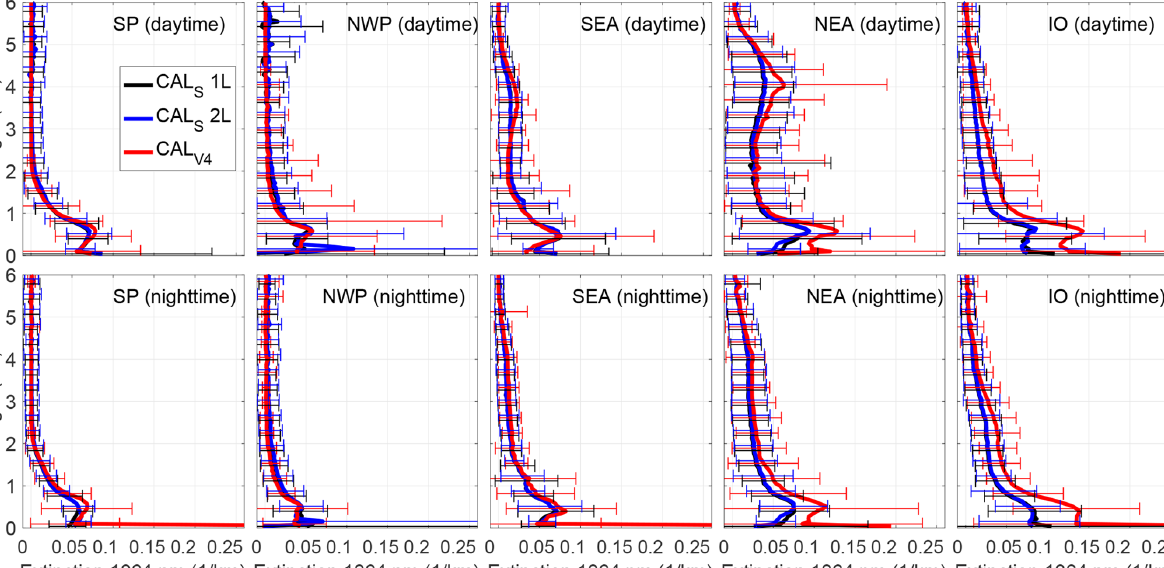
Figure 7. As in Fig. 6 but for the 1064nm